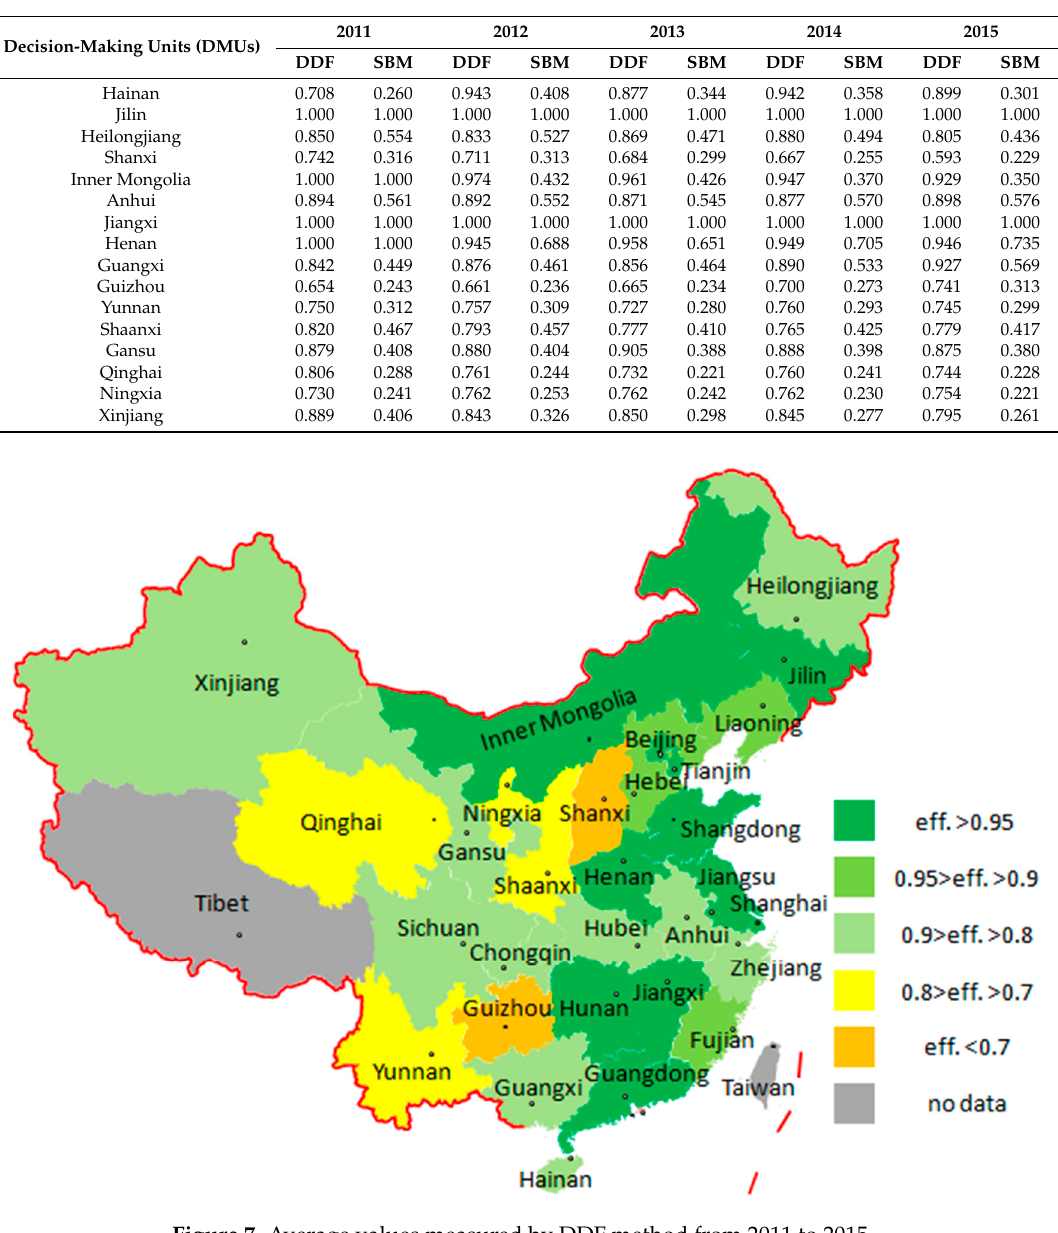
Figure 7. Average values measured by DDF method from 2011 to 2015.